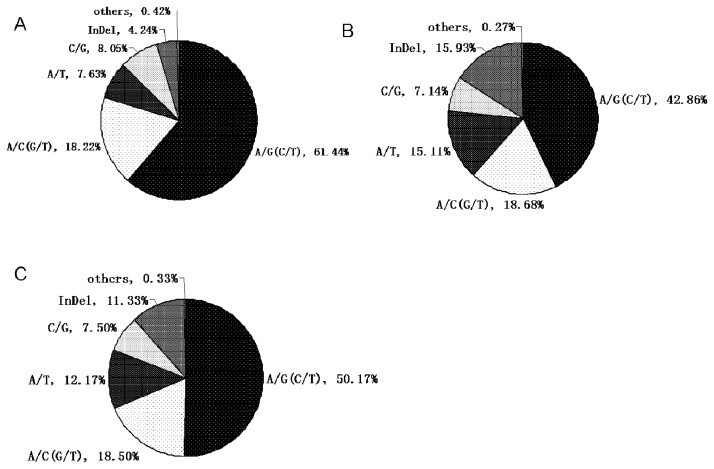
Distribution of different kinds of nucleotide variances in exons (A), introns (B) and complete sequences (C) in successfully amplified sequences.